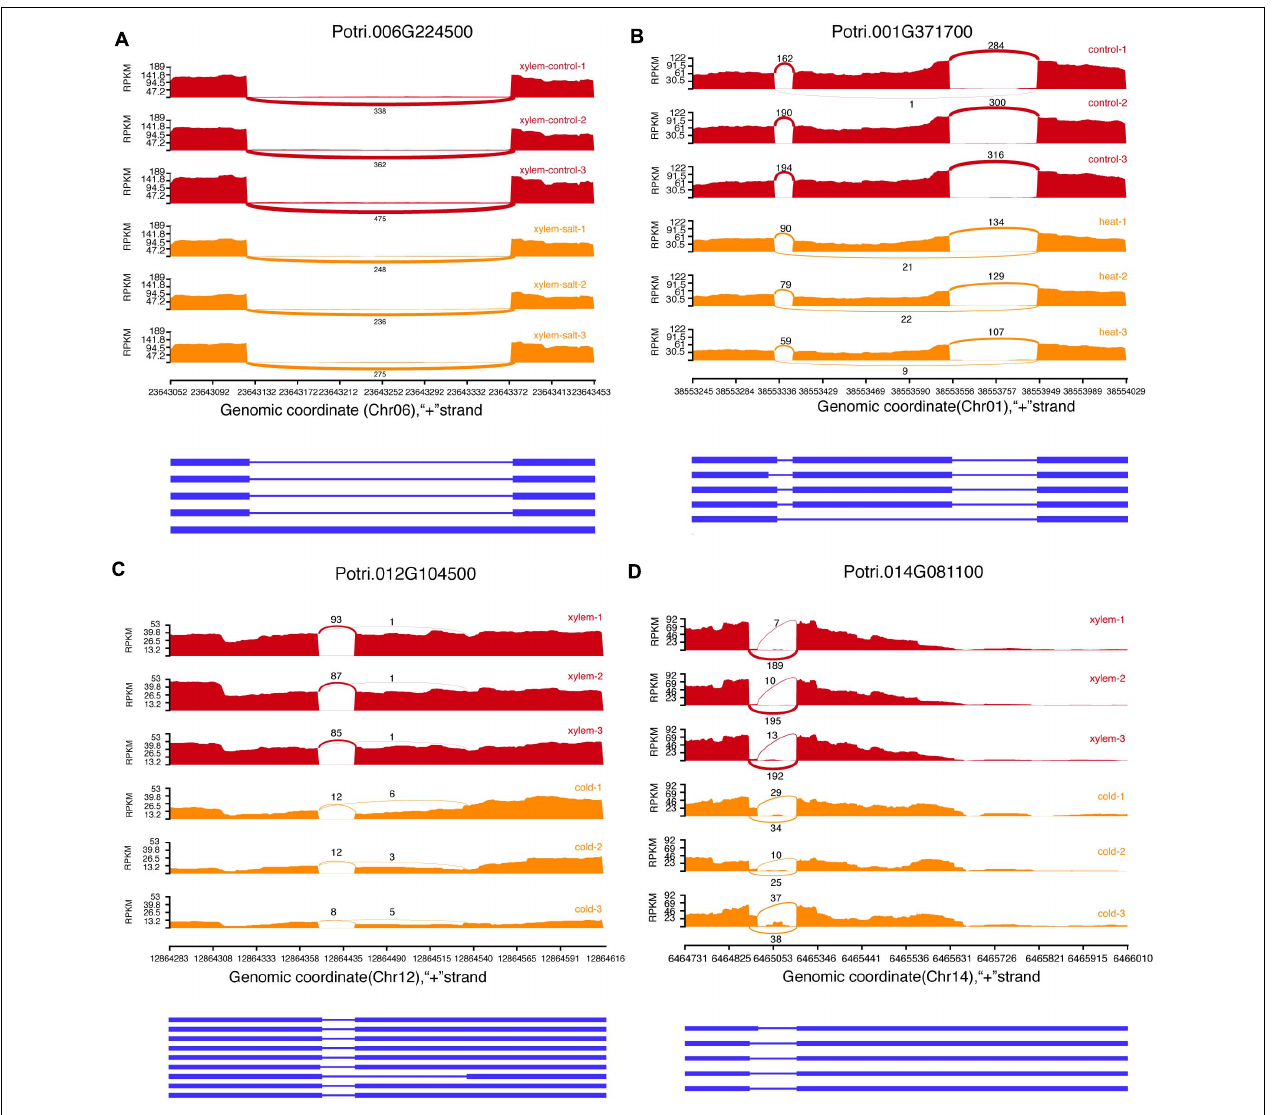
FIGURE 3 | Examples of four alternative splicing events. (A) Intron retention (IR). (B) Exon skipping (ES). (C) Alternative acceptor sites (AltA). (D) Alternative donor sites